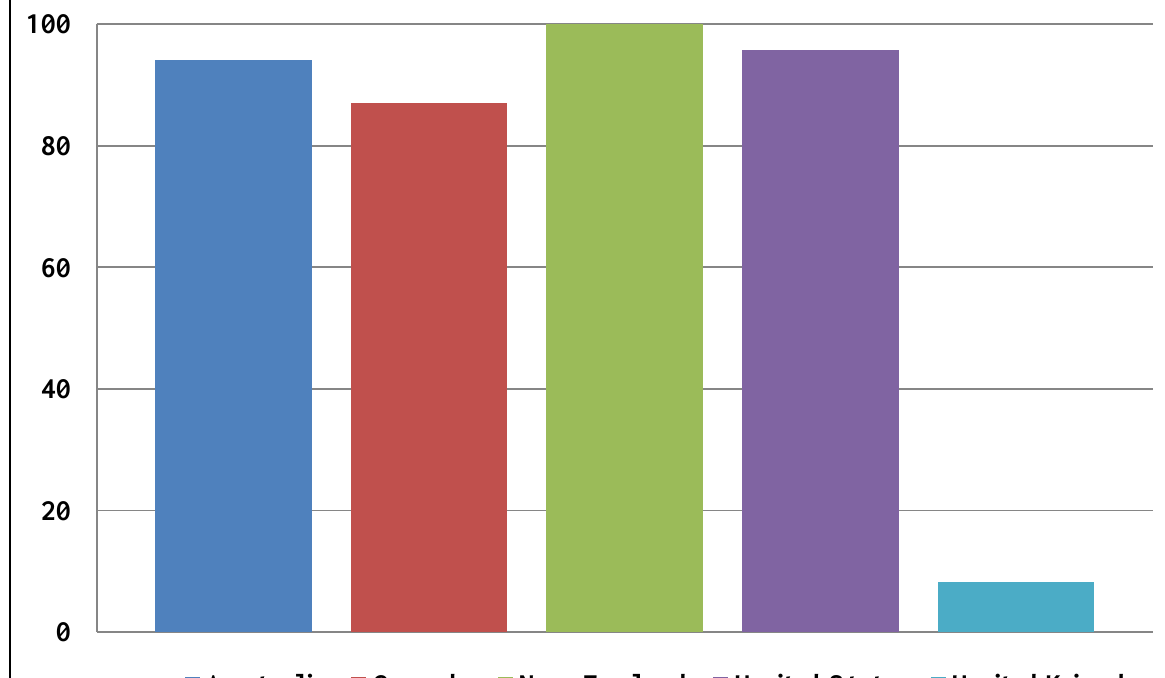
Figure 3: Raw Material Exports as % of Total Exports in